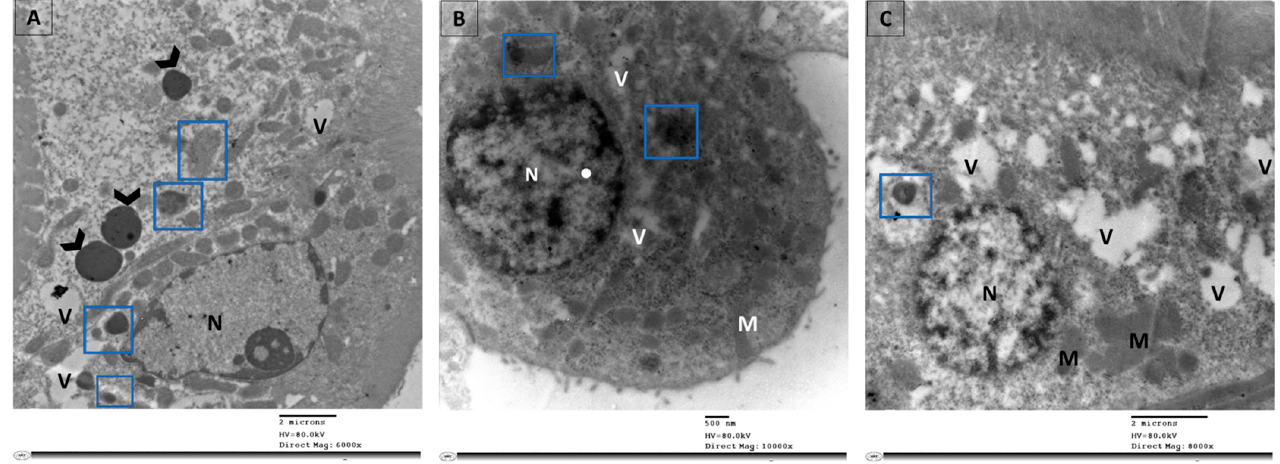
Figure 8. Selected micrographs by TEM of renal cells in the rapamycin groups displayed augmented apoptosis with little autophagy. Augmented apoptosis was evident as the chromatin condenses at the periphery of the nucleus (N) in addition to the abundance of apoptotic bodies (arrowhead) and vacuoles (V). The autophagic dynamic was disrupted as there were few phagocytic vesicles stuck as autophagosomes (blue square) with no autolysosomes. ( A ) A cellular behavior distinctive of apoptosis involves advanced margination and compacting of chromatin under the nuclear membrane, apoptotic bodies (arrowhead) and vacuoles (V). In addition, few autophagosomes (blue square) are found. ( B ) The collapse of cytoskeleton is indicated by diminished cell and shrunken nucleus (N), with an abundance of few number of vacuoles (V) and autophagosomes (blue square). ( C ) Atrophied nucleus with nuclear pores appears close to the areas of compact chromatin, extensive vacuolation (V) of the cytoplasm, fused mitochondria (M), and scarce autophagosomes (blue square).